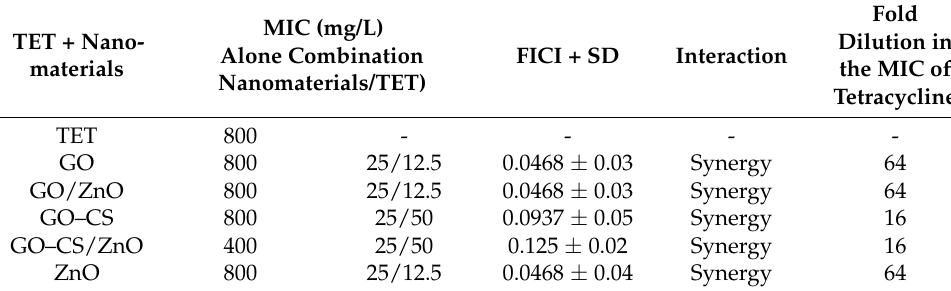
Table 1. Interaction study of nanomaterials with tetracycline against